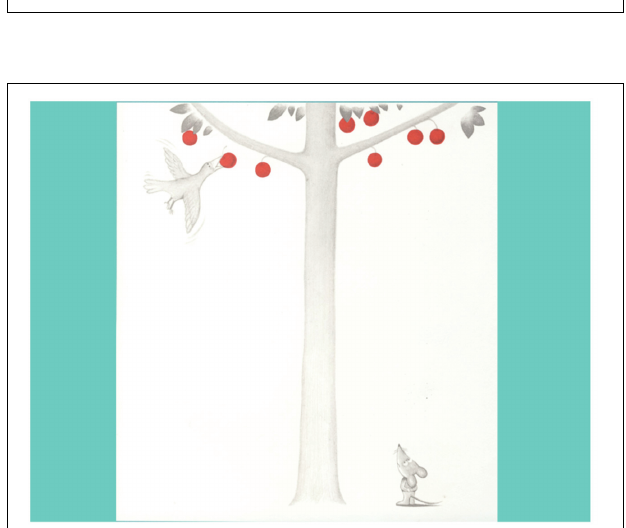
FIGURE 2 | Sample page from the wordless picture